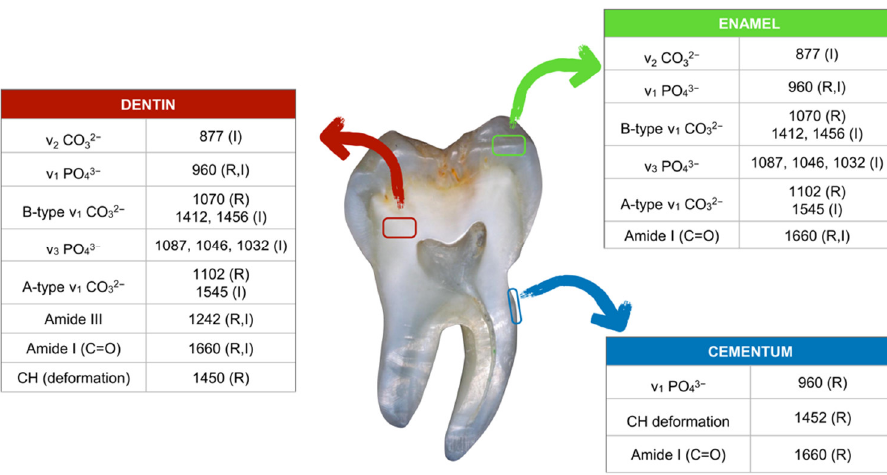
Figure 1. Main Raman (R) and IR (I) peaks of enamel, dentin, and cementum, together with the corresponding vibrational modes (ν: stretching vibration).